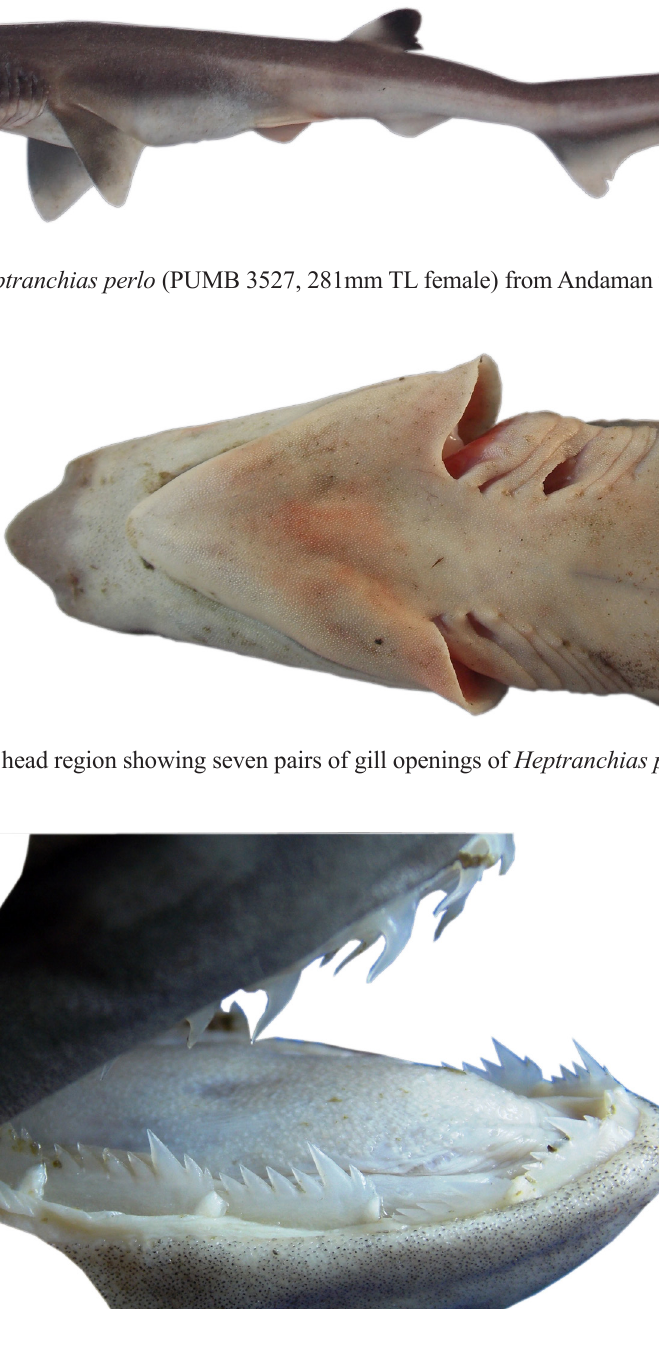
Fig. 4. Comb-shaped dentition of Heptranchias